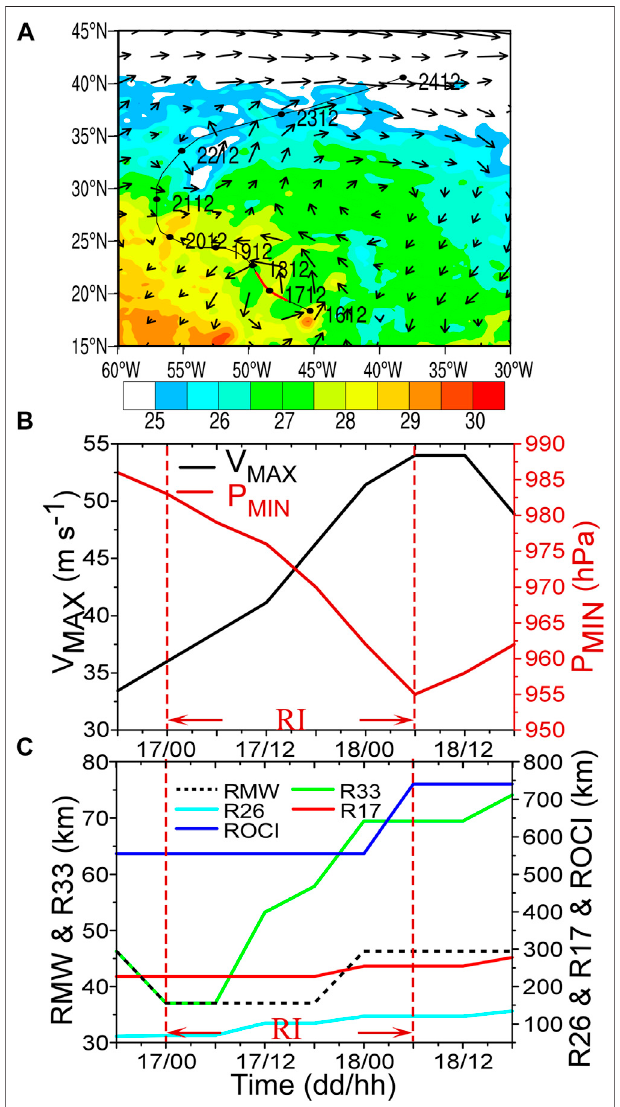
sustained surface wind (V MAX , black solid contour, m s − 1 ) and the minimum sea-levelpressure(P MIN ,redcontour,hPa)fromtheNationalHurricaneCenter (NHC) dataset, and (C) the radii of the V MAX (RMW, black dashed lines, km), 34 kt wind (R17, red solid line, km), 50 kt wind (R26, cyan line, km) and 64 kt wind(R33,greenline,km)from1800UTC16to1,800UTCSep18,2006.The red solid line in (A) and red dashed lines in (B, C) indicate the RI period.